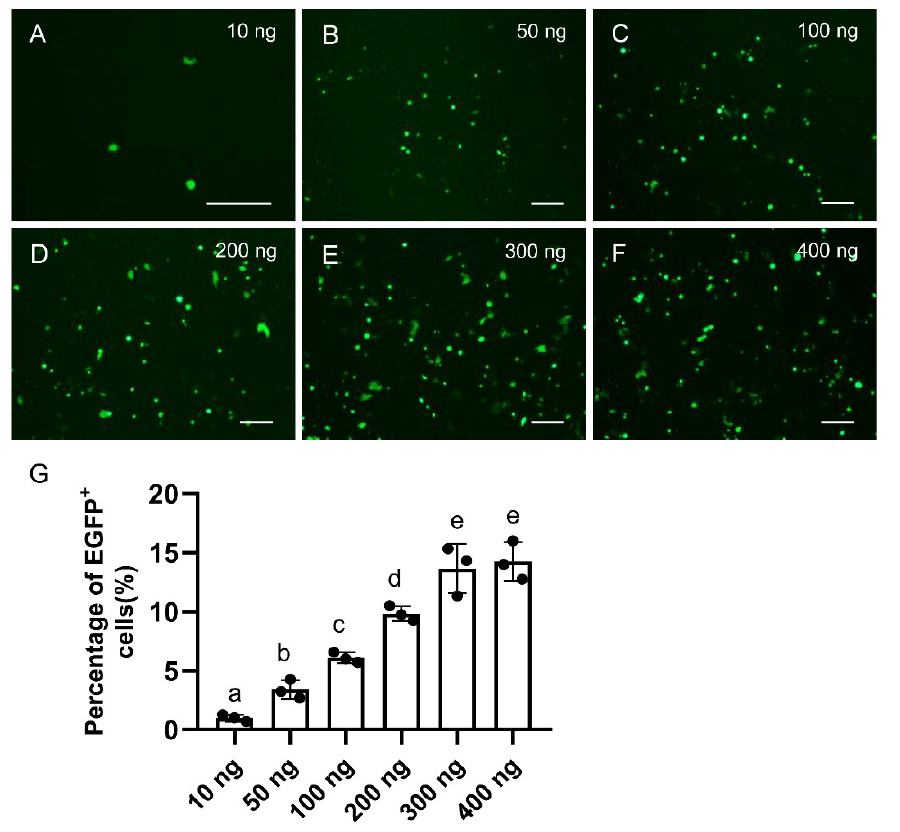
Figure 2. The dosage optimization of pCas9-mU6sgNtsf1 on its gene editing efficacy. ( A – F ) SG3 cells in 24-well plates were transfected with pCas9-mU6sgNtsf1 at different doses (10 ng, 50 ng, 100 ng, 200 ng, 300 ng and 400 ng) and pGNtsf1 (200 ng), the cells were monitored under fluorescent microscopy to evaluate the gene editing efficacy 48 h after transfection. Scale bars, 100 μm. ( G ) Quantification of the percentage of EGFP + in different groups. Data are shown as means ± standard derivation. Different letters above the bars represent significant differences between the groups ( p < 0.05).